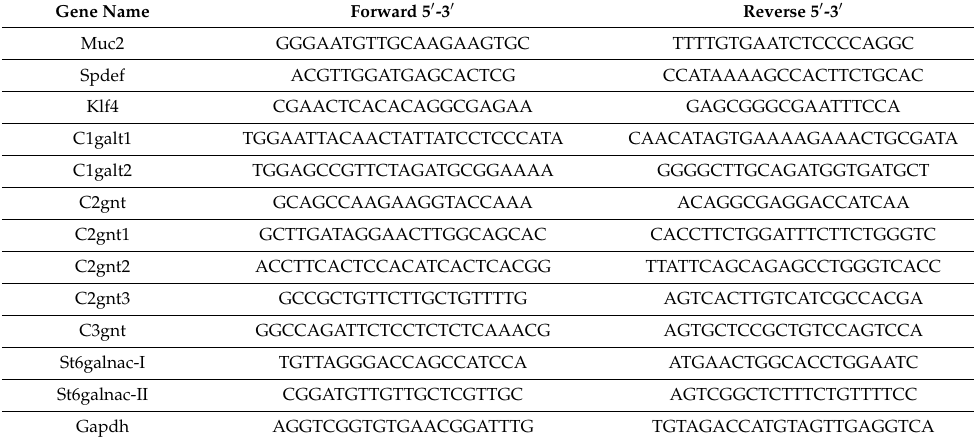
Table 1. Primer sequences of